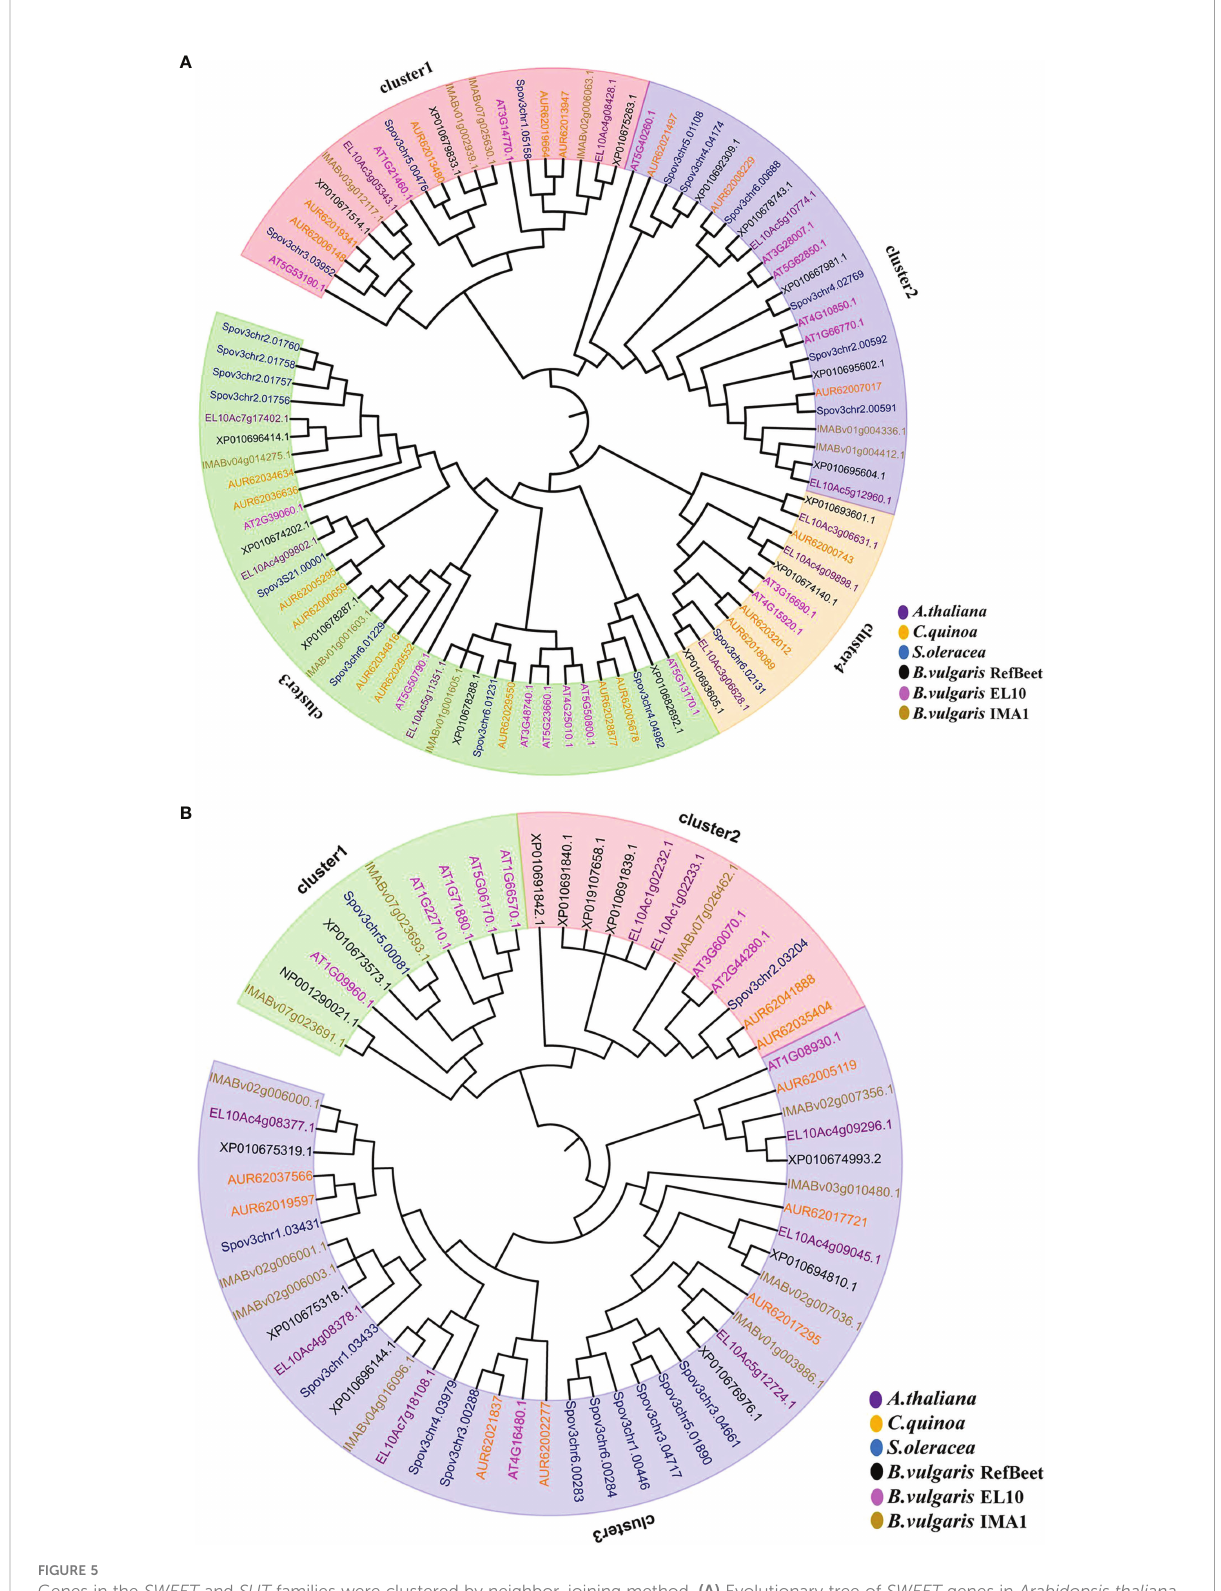
FIGURE 5 Genes in the SWEET and SUT families were clustered by neighbor-joining method. (A) Evolutionary tree of SWEET genes in Arabidopsis thaliana , Chenopodium quinoa , Spinacia oleracea , and Beta vulgaris IMA1, EL10, and RefBeet. (B) Evolutionary tree of SUT genes in A. thaliana , C. quinoa , S.oleracea , and B. vulgaris IMA1, EL10, and